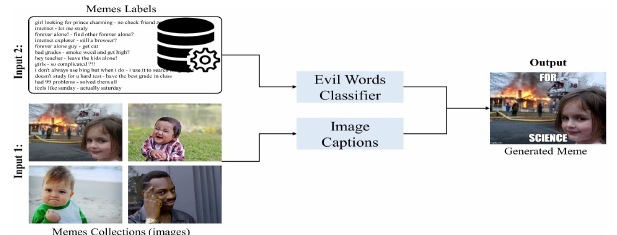
Figure 3. Conceptual diagram for the proposed memes